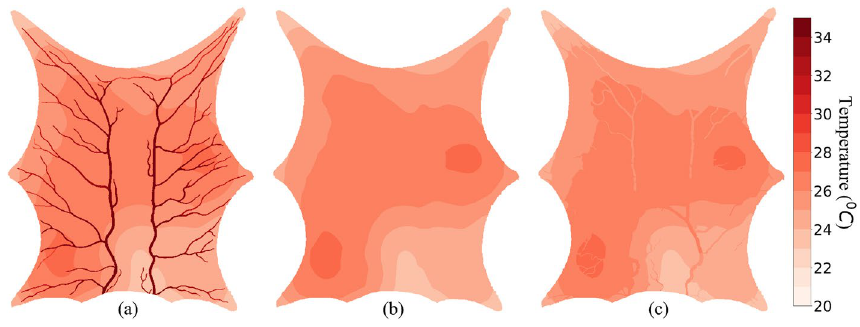
2 ◦ C and ǫ = 10mm ( a ) Layer 1, ( b ) Layer 2, ( c )